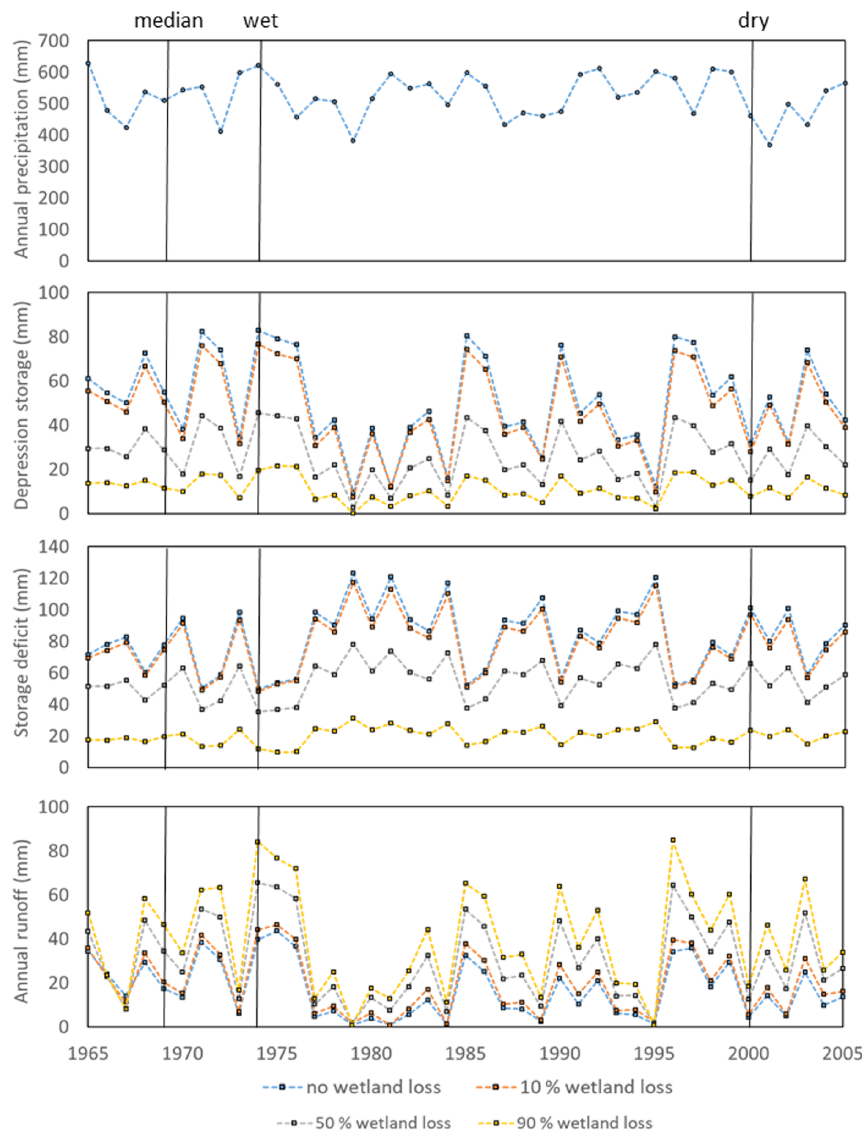
Figure 6. Time series of Yorkton annual precipitation and simulated depression storage, storage deficit, and runoff for the small-to-large drainage scenario. Black lines highlight specific extreme dry (2000), extreme wet (1974), and median (1969) years discussed in the